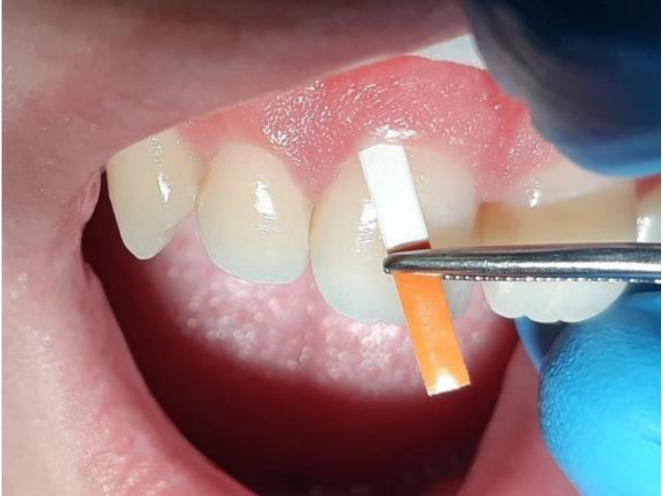
Figure 1. A Periopaper strip inserted into the gingival crevice (photo from own collection — K.N.). A clinical examination was performed in the last stage to prevent irritating the delicate periodontal tissues with the probe or affecting the fluid volume or the occurrence